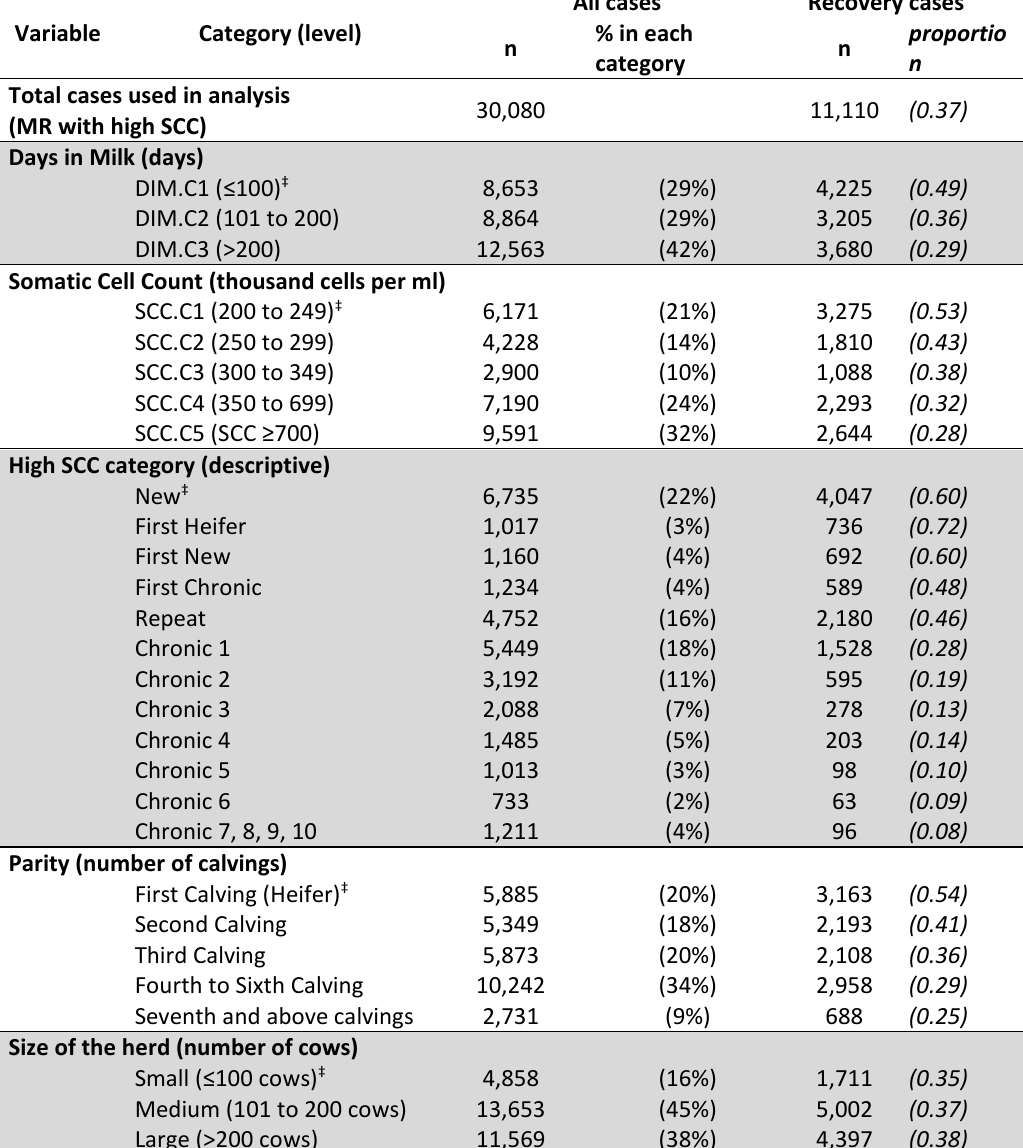
Table 2 : Distribution of cases by different categories of each of the variables used in the multilevel, mixed effect logistic regression model and the ‘raw’ recovery